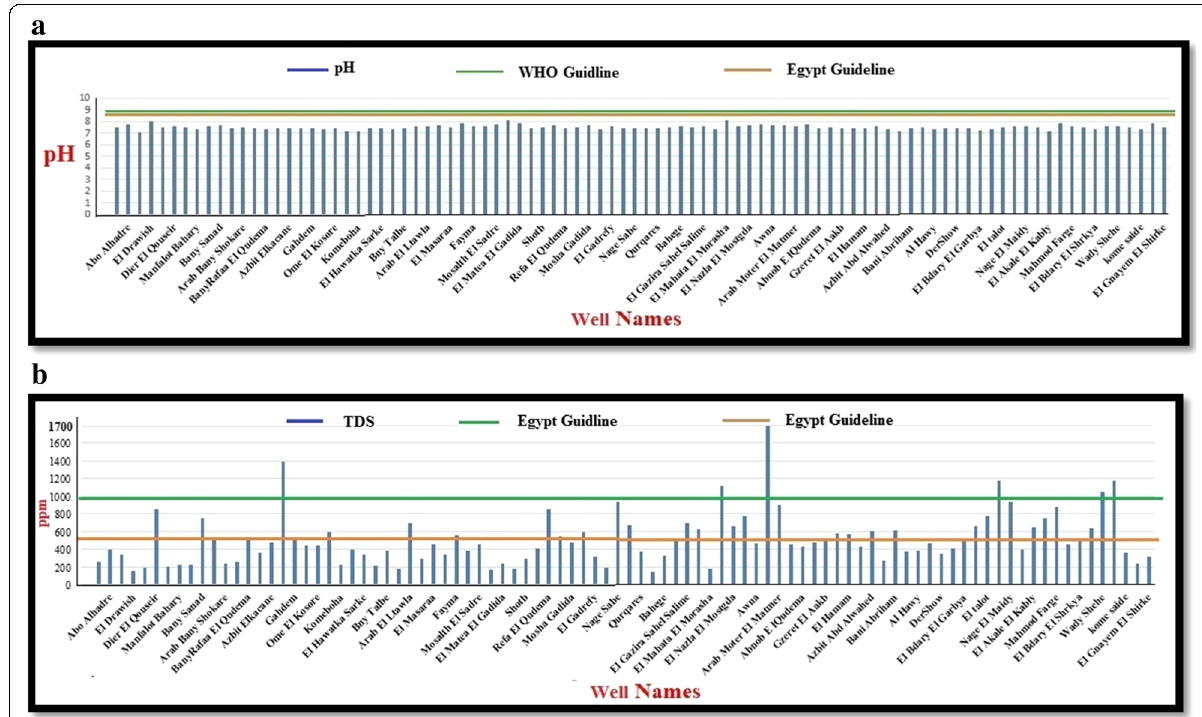
Fig. 7 a Hydrogen ion concentration and b total dissolved solids concentration in the groundwater samples compared with WHO Guidelines (2004) and Egyptian Higher Committee for Water (2007) guidelines for drinking